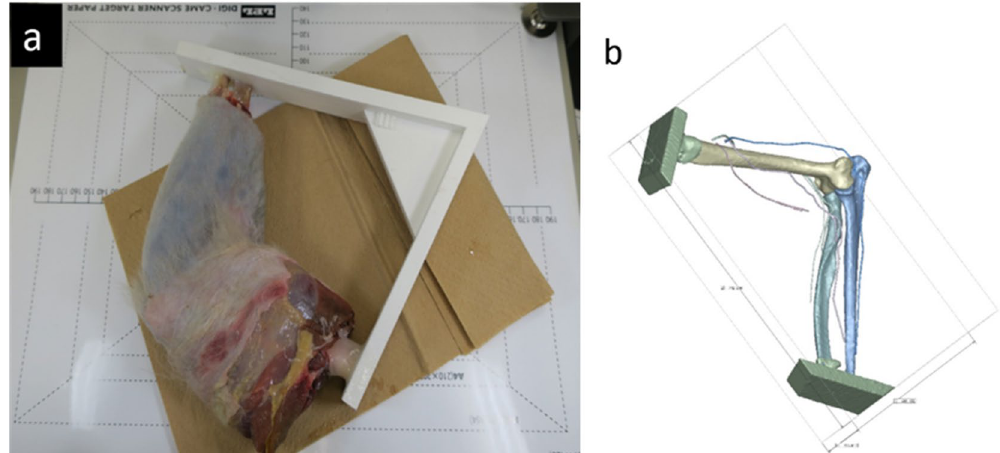
Figure 4. Elbow of a Japanese monkey cadaver and Standard Triangulated Language (STL) data. We used the elbow (1/2 of upper arm ~ 1/2 of forearm) of a Japanese monkey cadaver. From X-ray computed tomography (CT) data of the cadaveric elbow, we modeled frame data that can be precisely attached to humerus and ulna on the posture of 90° elbow flexion, 0° forearm pronation ( a ). We obtained bone segmentation from CT data and nerves from magnetic resonance imaging (MRI) data of a cadaveric Japanese monkey elbow. Segmentation and refinement were performed using VoTracer software (Riken, Wako, Japan) (http://www2.riken .jp/brict / Ijiri /VoTra cer). This figure was generated by Dr. Shintaro Oyama using L-Phinus V5 Ver. 5.01 software (https ://l-phinu s.jp/softw are.html) ( b